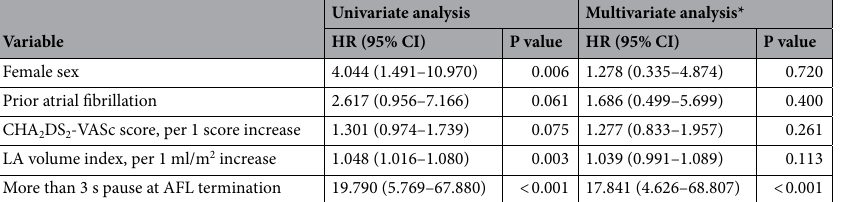
Table 4. Independent Predictors for PPM Implantation among the Patients Discharged without PPM Implantation after CTI dependent AFL Ablation. *The discriminant ability of multivariable model was